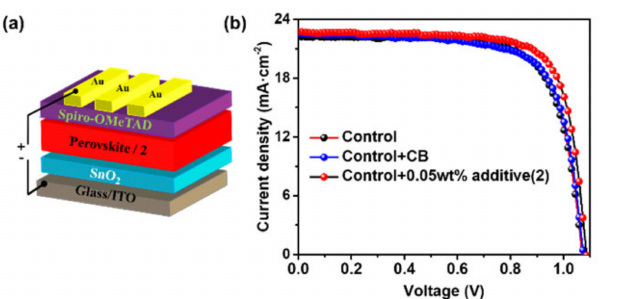
Figure 4. ( a ) Device structure of PSCs and ( b ) J-V curves of the devices with and without 2 measured under illumination of an AM 1.5 solar simulator (100 mW cm − 2 ) in